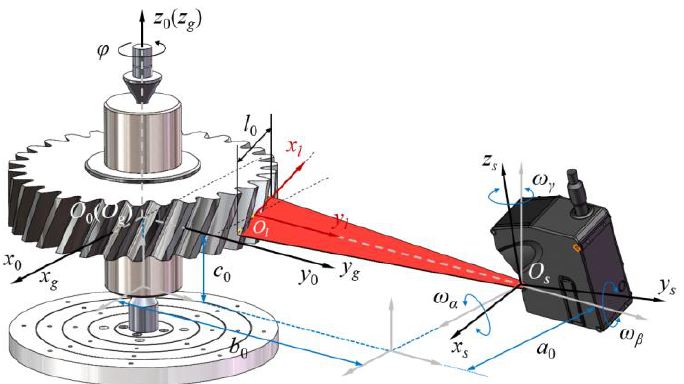
Figure 1. Coordinate system.